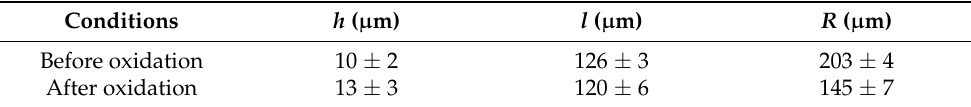
Table 1. The depth, span and calculated radius of a typical indent shown in Figure 1. Conditions h ( µ m) l ( µ m) R ( µ m) Before oxidation 10 ± 2 126 ± 3 203 ± 4 After oxidation 13 ± 3 120 ± 6 145 ± 7 Figure 3 shows a typical profile of the peak shift across an indent. The peak shift is nearly constant at the flat surface and decreases to almost zero at the edge of the indent, and then increases to a constant value across most of the central part of the indent. Significant decohesion of TGO from substrate is inferred to occur at the edge of the indents, hence leading to zero stress in the TGO. The following study will focus on the peak shift of TGO at the central part of indents.